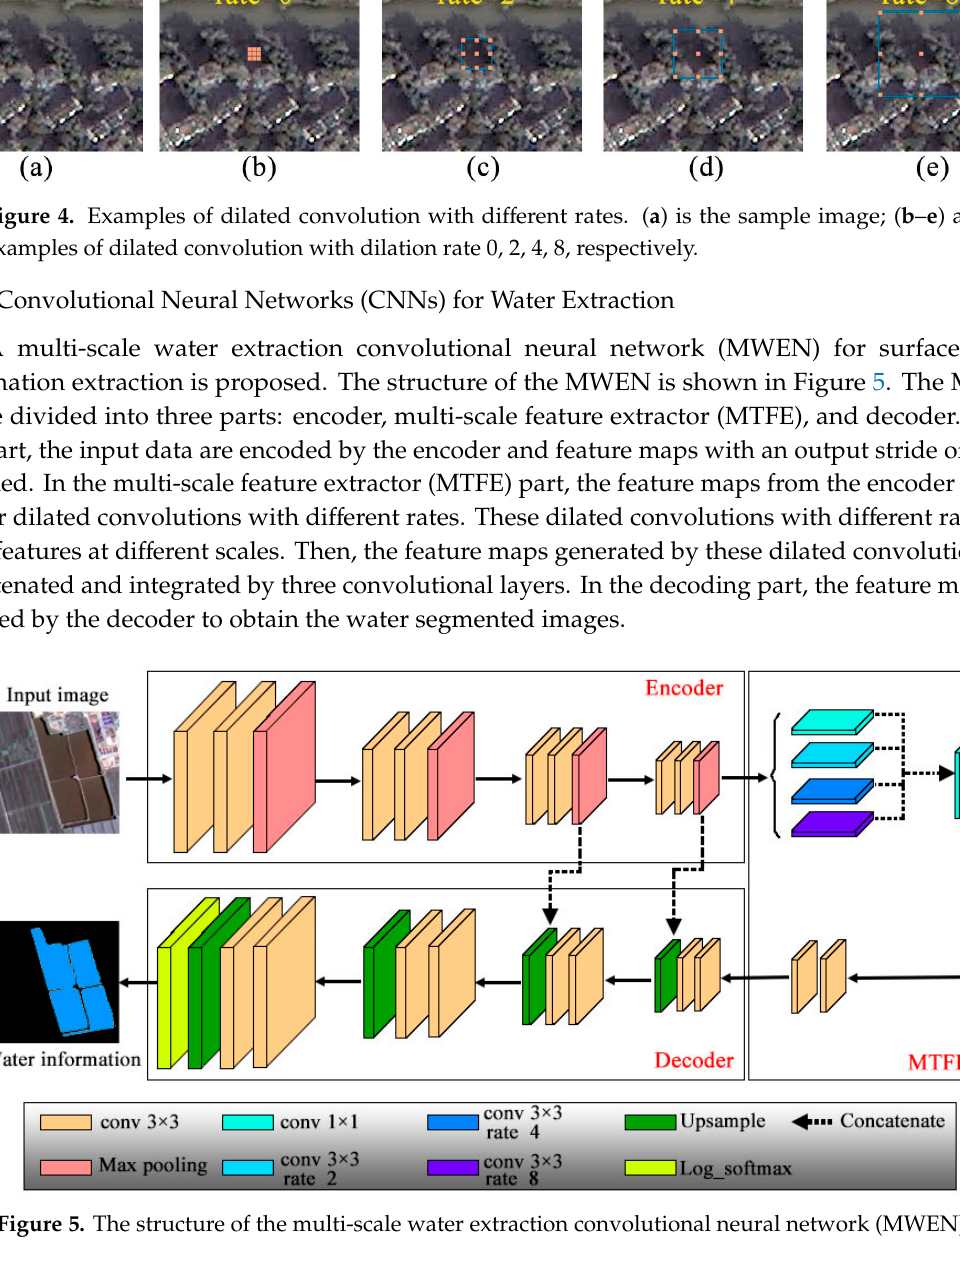
6 of 19 Figure 3. Dilated convolution kernels with different rates. (a), (b), (c) are dilated convolution kernels